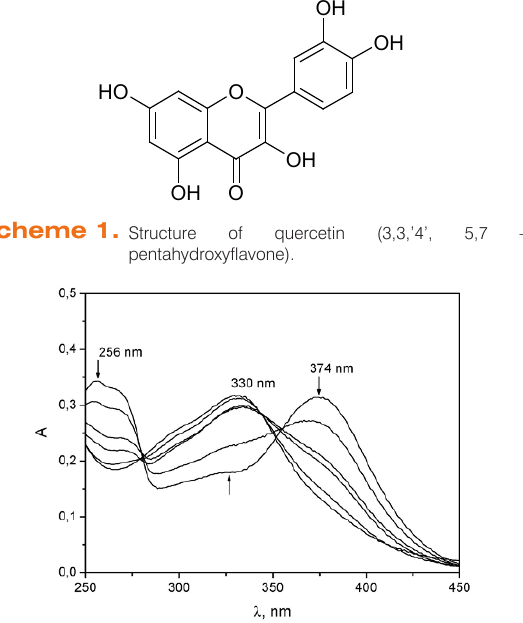
Figure 1. Absorption spectra of 17 µM quercetin taken after 1 min incubation with peroxynitrite at concentrations: 0, 25, 50, 75, 100 and 150 µM, at pH 7.2.